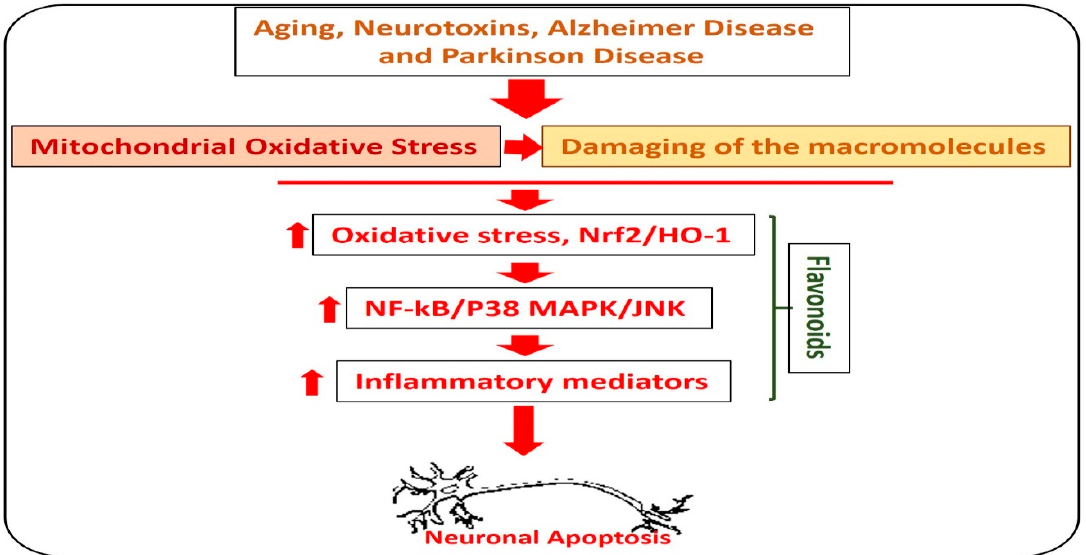
Figure 3. Role of flavonoids in the management of neurodegenerative diseases. A diagram showing the role of hesperetin in the management of neurodegenerative diseases. The image highlights the role of flavonoids against aging, Parkinson’s disease, and Alzheimer’s disease-induced neurodegenerative conditions. As with neurodegeneration, there is an elevation in the level of reactive oxygen species, which facilitates the neuroinflammation by activating the NF-kB and MAP kinases, and release of inflammatory cytokines and neurodegeneration. Interestingly, these effects were markedly reduced with the administration of flavonoids.